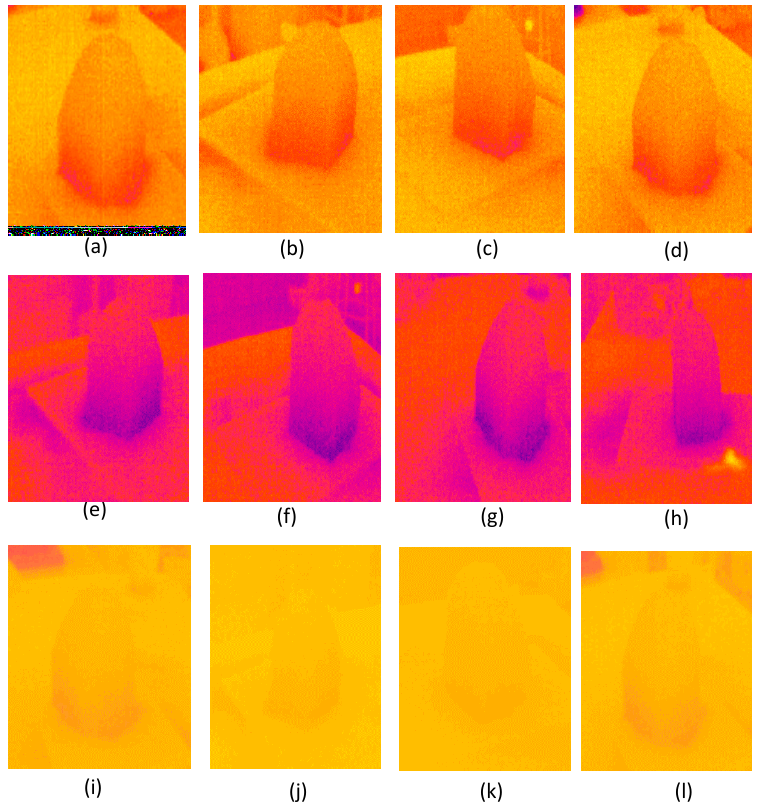
Figure 9. Model thermal and humidity analyses in the laboratory: ( a – d ) model thermal image 24–28 degrees; ( e – h ) model thermal image 25–29 degrees; ( i – l ) model humidity, 65–66% rh with 28 degrees using a thermal scanner 875-2i (source: authors).